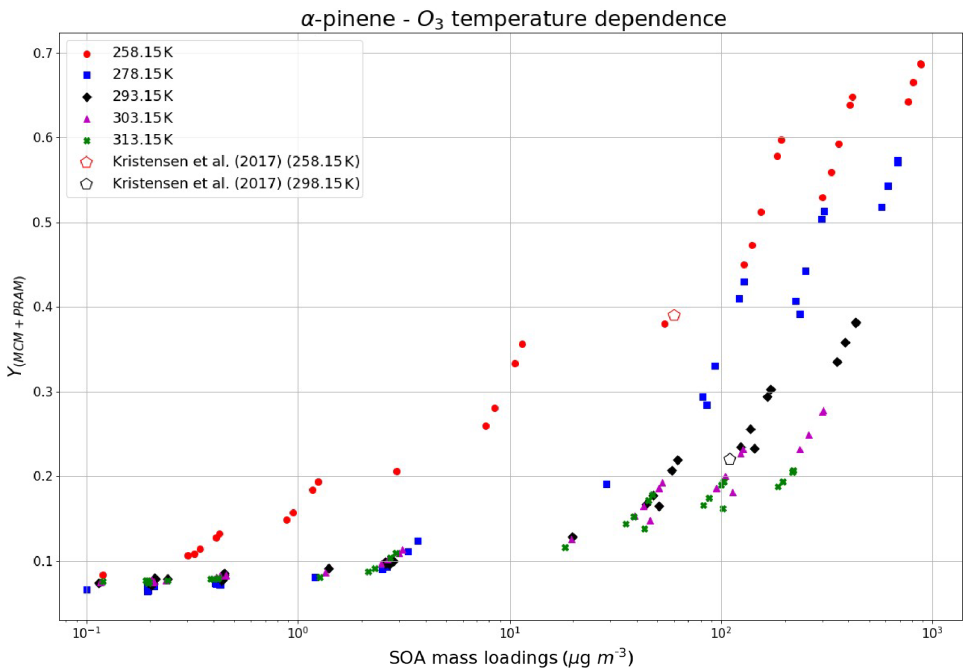
Figure 8. Temperature dependence of SOA mass yields at different temperatures using the MCM + PRAM. The open pentagons represent measurement data from Kristensen et al. (2017) at 258.15 and 298.15K.